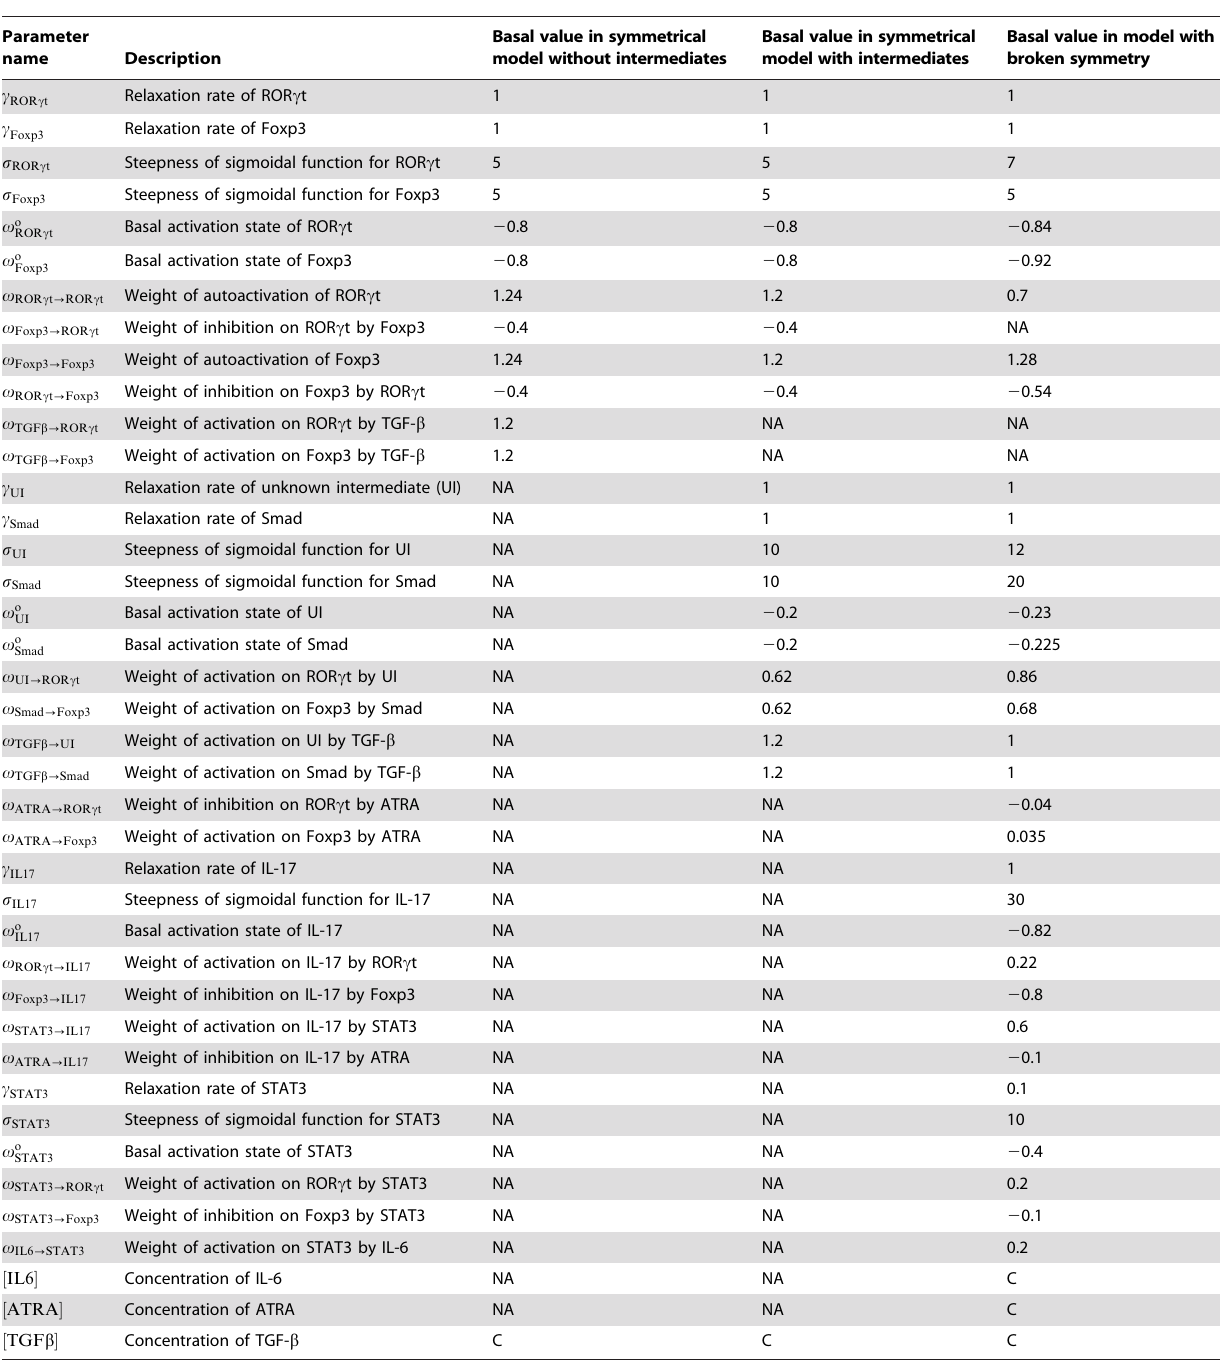
Table 1. Descriptions and basal values of parameters.